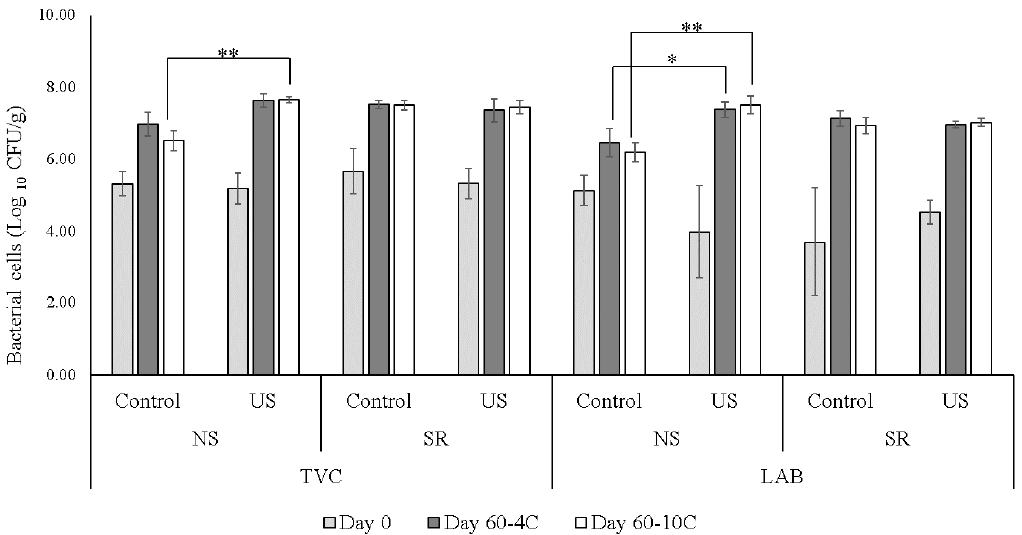
Figure 5. Total viable counts (TVC) and lactic acid bacteria (LAB) counts at day 0 and after 60 days of storage at 4 °C and 10 °C. Comparison between samples contained normal sodium levels (NS) and reduced sodium levels (RS) and processed with ultrasound (US) or without (control). Differences between treatments are significant at * p -value < 0.05, ** p -value < 0.01 .